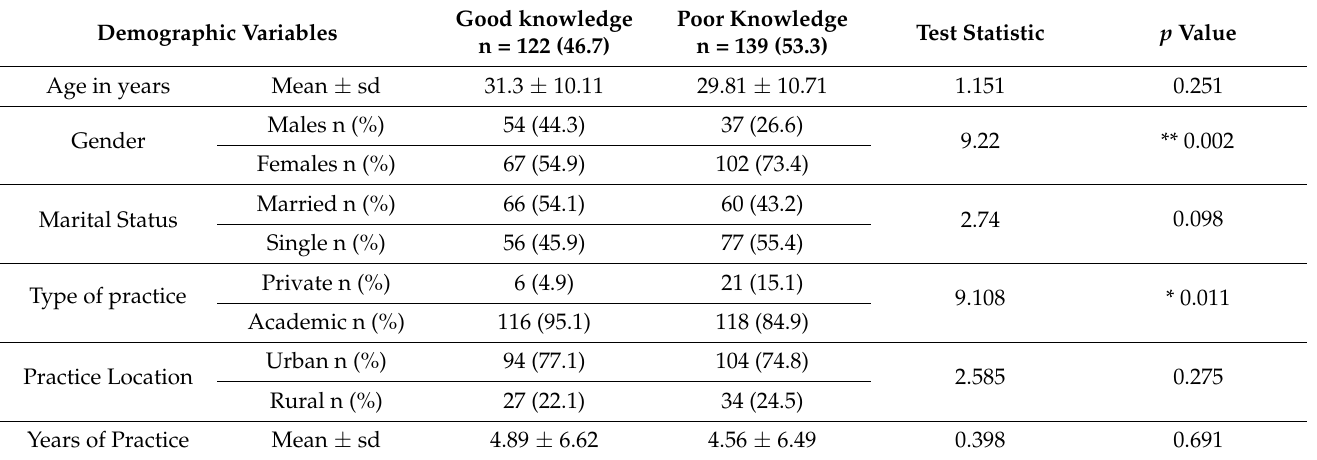
Table 3. Comparison of the demographic variables in relation to the level of knowledge (chi-square test for independence of attributes).